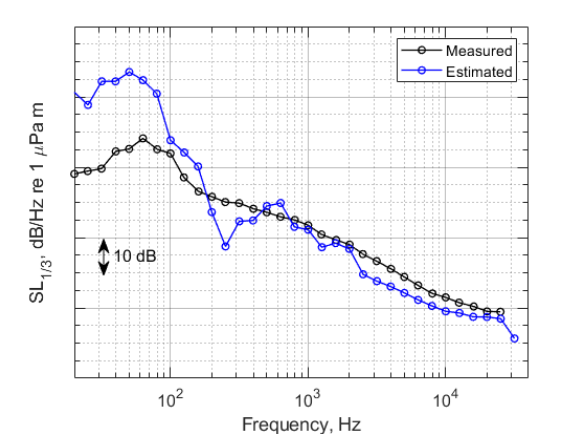
Figure 20. Comparison of measured and estimated source levels for condition C 1.